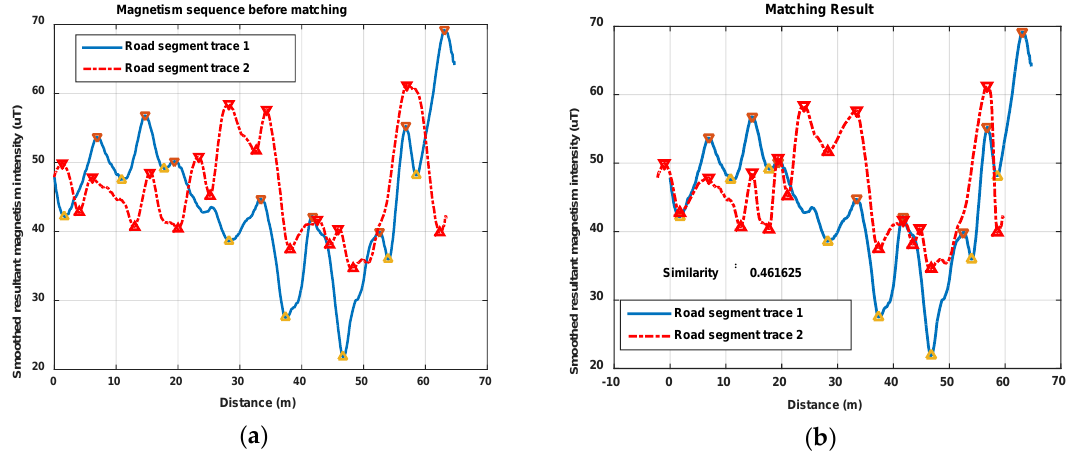
Figure 14. Magnetism matching and similarity calculation results for two traces generated on different road segments: ( a ) smoothed magnetism sequences and detected features marked by the initial estimated distance; ( b ) magnetism sequences after feature matching and sequence zooming, and the calculated similarity between them.